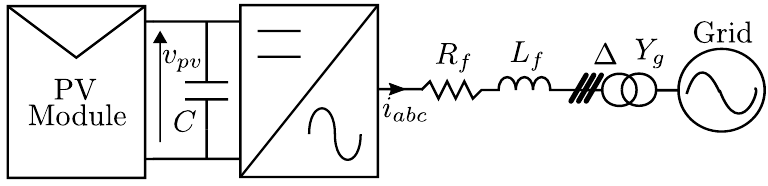
Figure 2. Single-stage connection of a PV module to the electric grid.